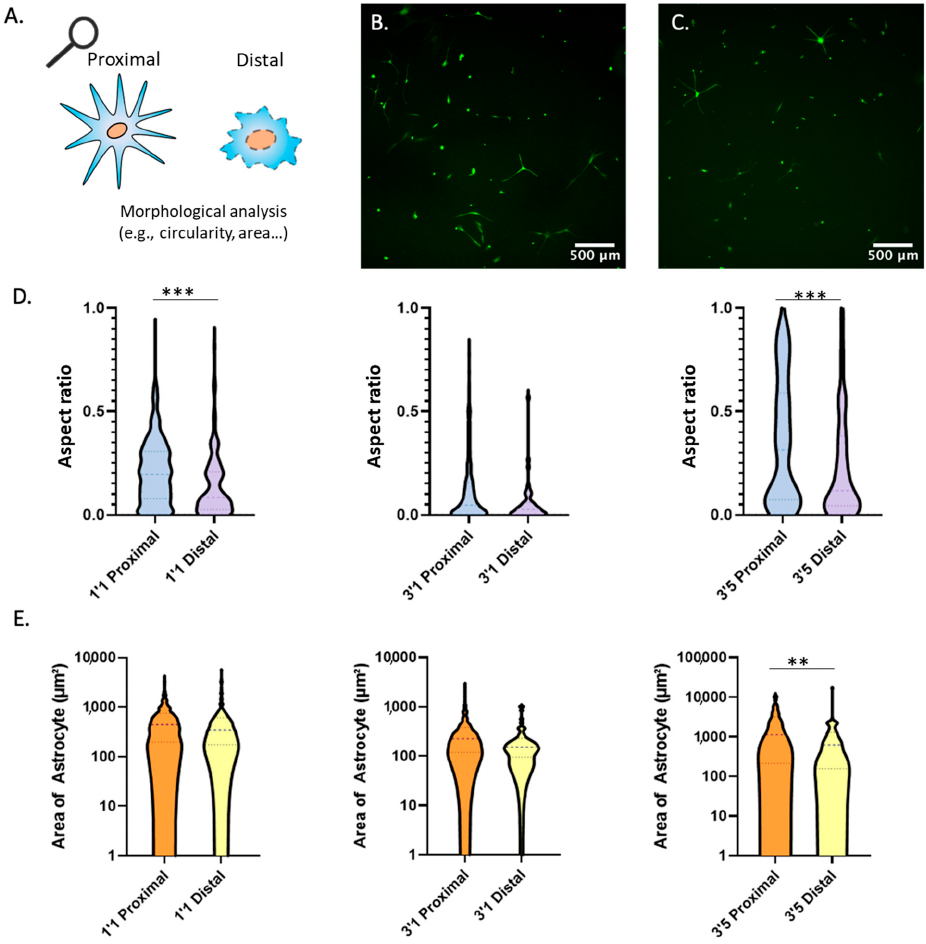
Figure 5. Morphological Analysis. ( A ) Illustration depicting methodology for circularity morphological analysis. ( B ) Astrocytes extracted from the proximal region of the device after 3 days and placed in culture for 5 days prior to imaging. ( C ) Astrocytes extracted from the distal region of the device after 3 days and placed in culture for 5 days prior to imaging. ( D ) Violin graphs analyzing circularity of astrocytes at multiple time points after extraction from proximal and distal regions of the device. ( E ) Violin graphs analyzing area of astrocytes at multiple time points after extraction from proximal and distal regions of the device. ** and *** denote p-value < 0.01 and 0.005 respectively.